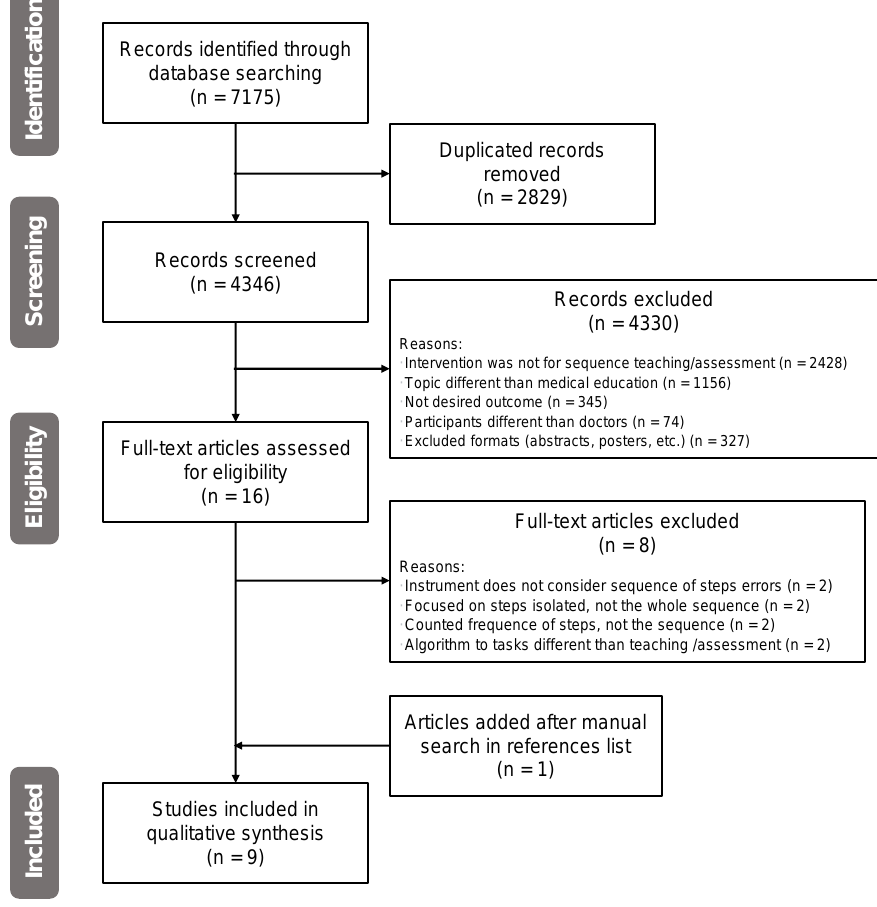
Figure 1. PRISMA flowchart, based on